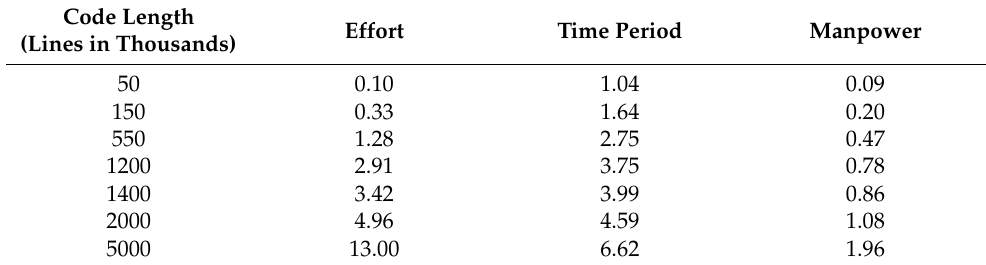
Table 2. Approximated values of COCOMO